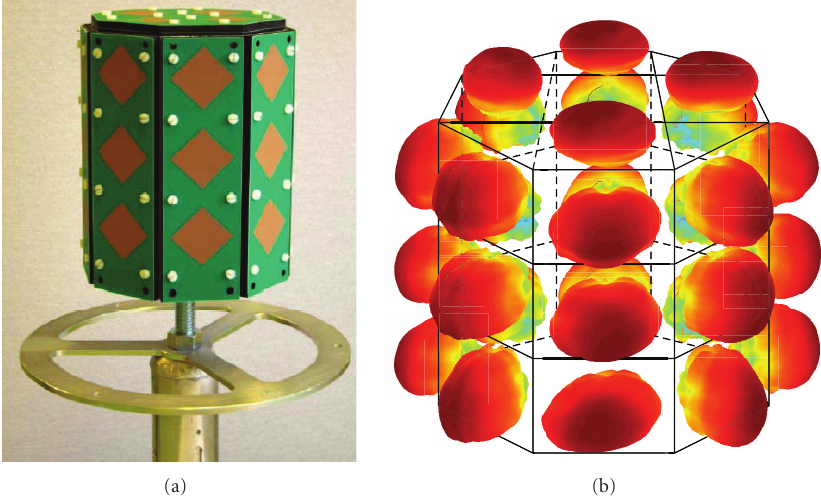
Figure 3: The configurations and antenna pattern of ODA: (a) configurations; (b) antenna